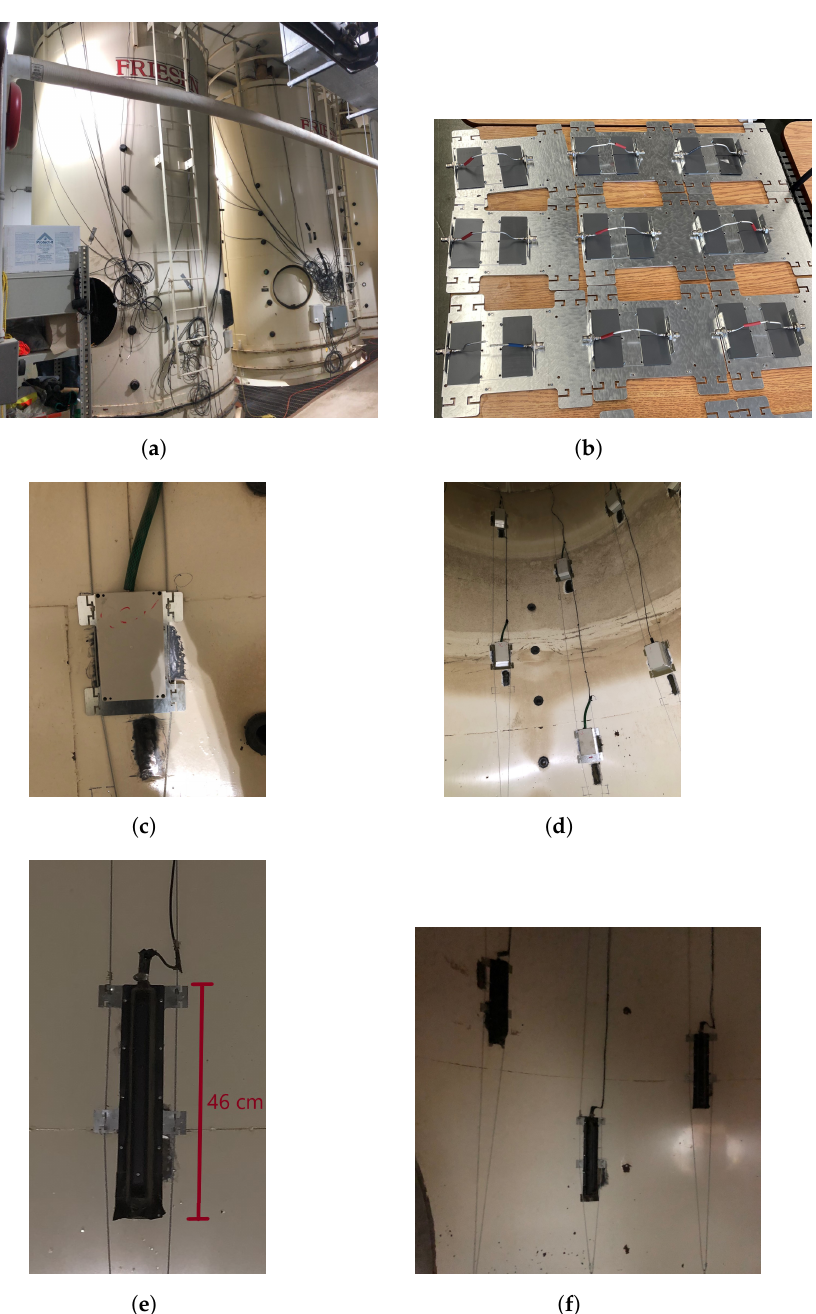
Figure 13. Large bin experiment. ( a ) Two, 28 m 3 (800 bushel) bins, ( b ) Nine FLAs under construction, ( c ) close up of an FLA inside its enclosure in the left bin, ( d ) installed FLAs in the left bin, ( e ) close up of NFLA in the right bin, ( f ) installed NFLAs in the right bin. The area of the FLA loop antenna is 42 cm 2 , while the area of the black NFLA loop antenna is ≈ 527 cm 2